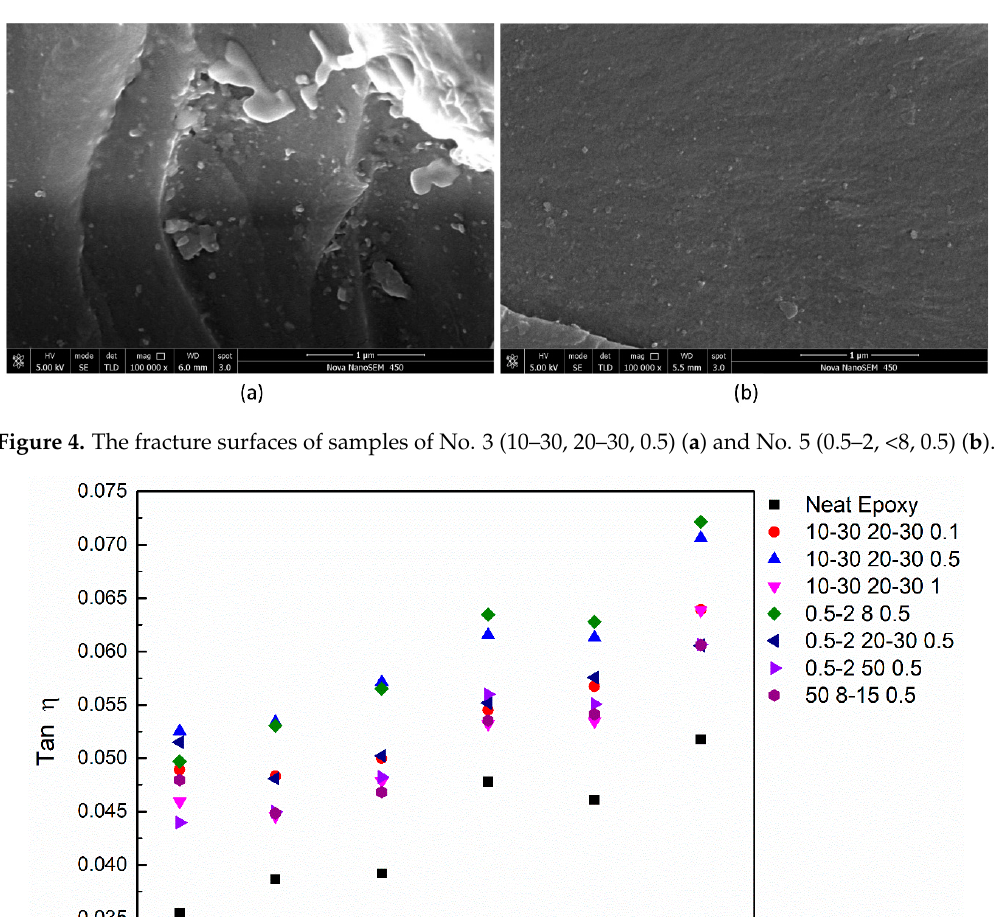
Figure 3. Agglomerates on the fracture surfaces of samples No. 8 (50, 8–15, 0.5) ( a ) and No. 4 (10–30, 20–30, 1) ( c ); internal morphology of the corresponding agglomerates ( b) , ( d ).